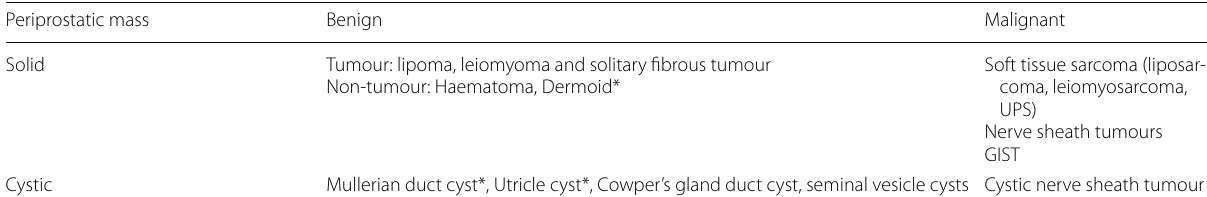
*May rarely develop malignant degeneration